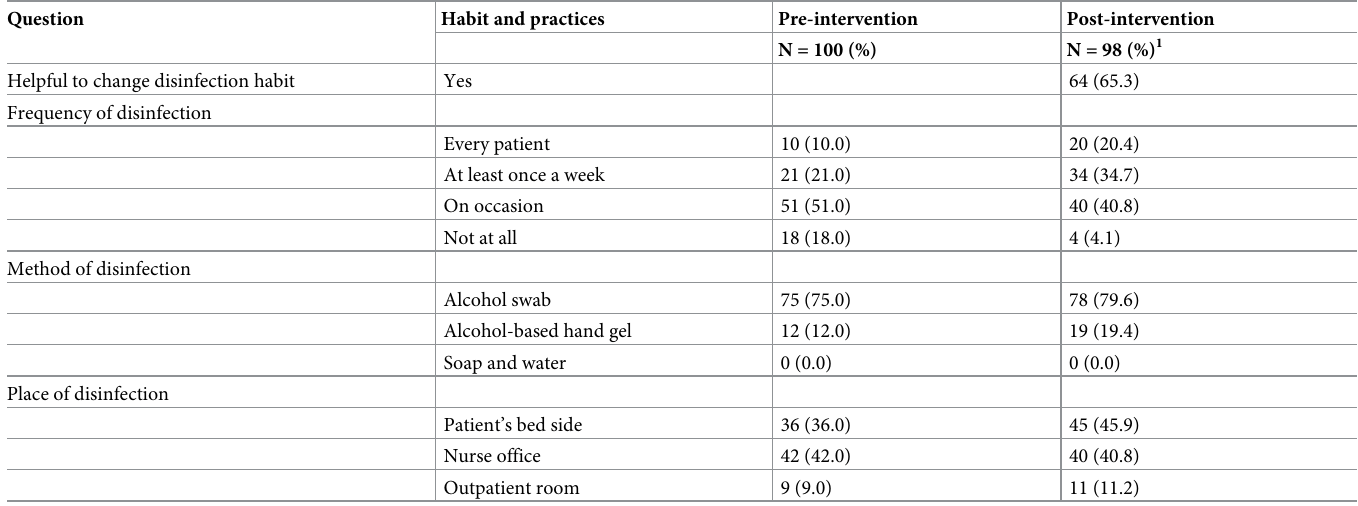
Table 2. Disinfection habit changes of the participants after